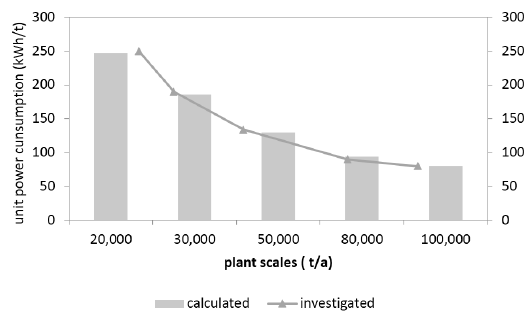
Figure 10. Calculated and investigated energy consumption.